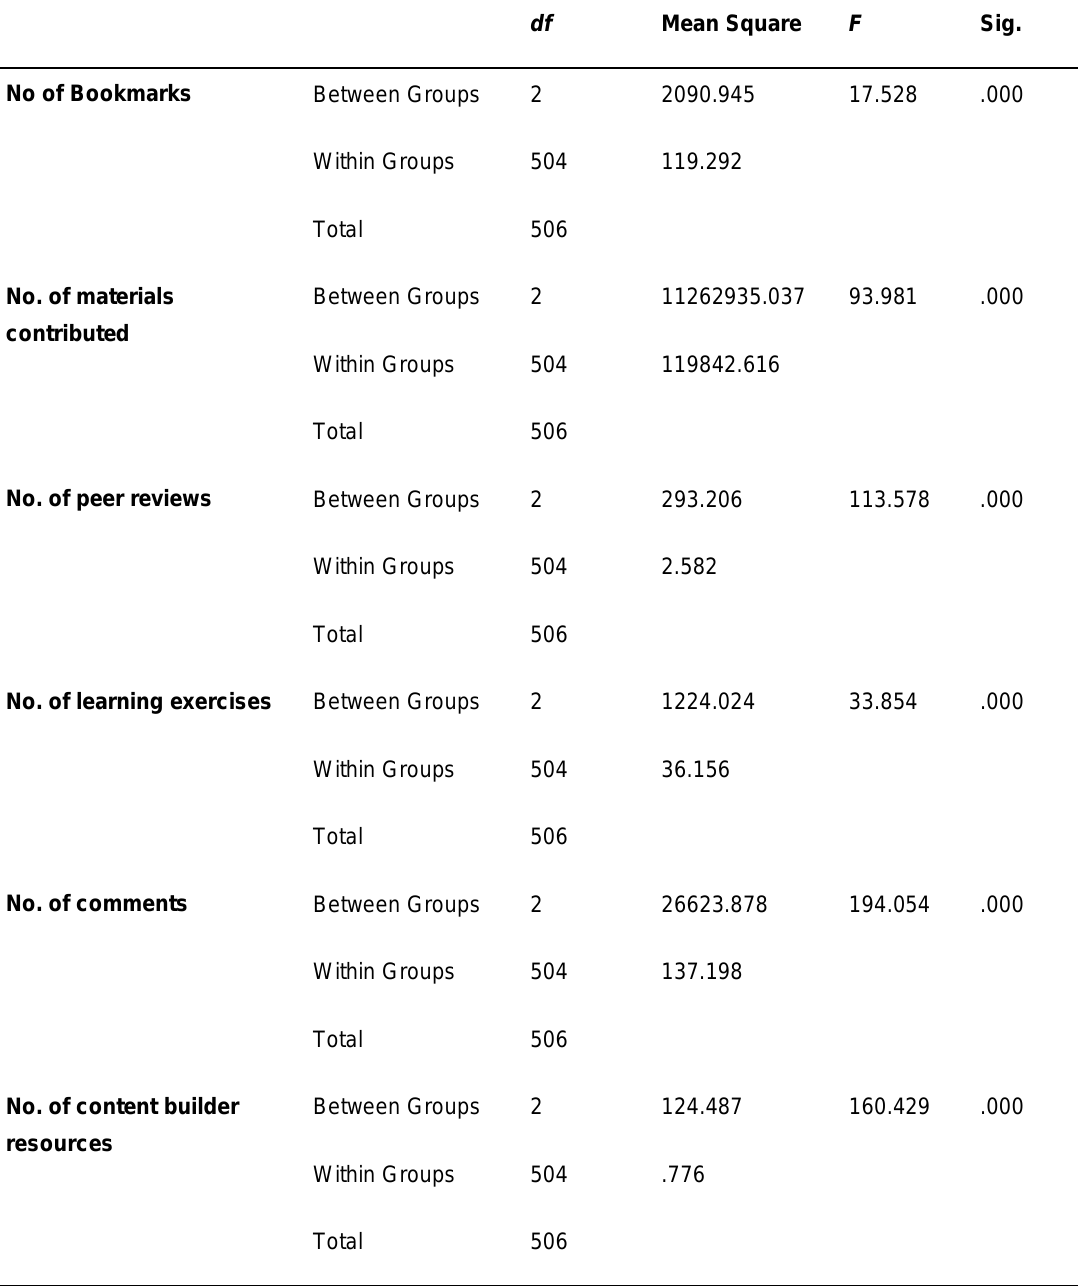
df Mean Square F Sig.